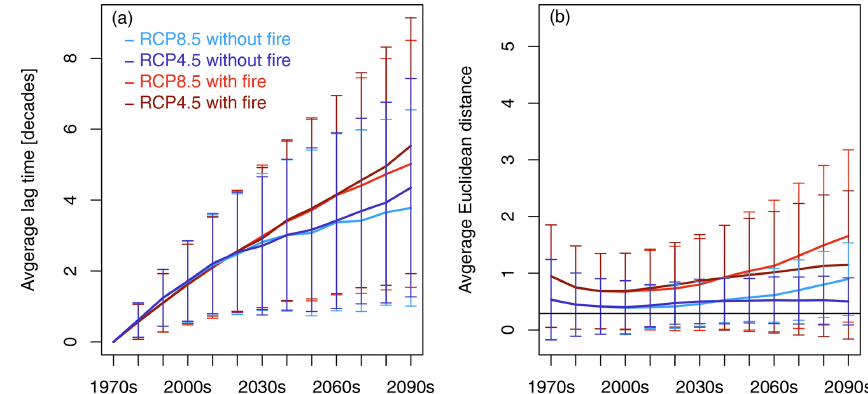
Figure 5. Continental-scale spatial average of lag time (a) and residual distance (b) between transient decade and most-similar equilibrium decade (closest-decade partners (CPDs) based on Euclidean distance) for the four scenario pairings between CDPs. Error bars represent standard deviation of spatial averages in a given decade. The horizontal black line at 0.29 in (b) indicates the threshold value above which Euclidean distance is assumed to be significantly different from zero. Lag time increases over time for all scenarios, and scenarios with fire start to diverge from scenarios without fire after 2030. Residual distances between CPDs are different from zero and indicate that transient vegetation states are not time-shifted trajectories of equilibrium vegetation states. To see which variables are the main drivers of the spatially averaged residual distance shown in (b) , please view (b) in comparison with Fig.